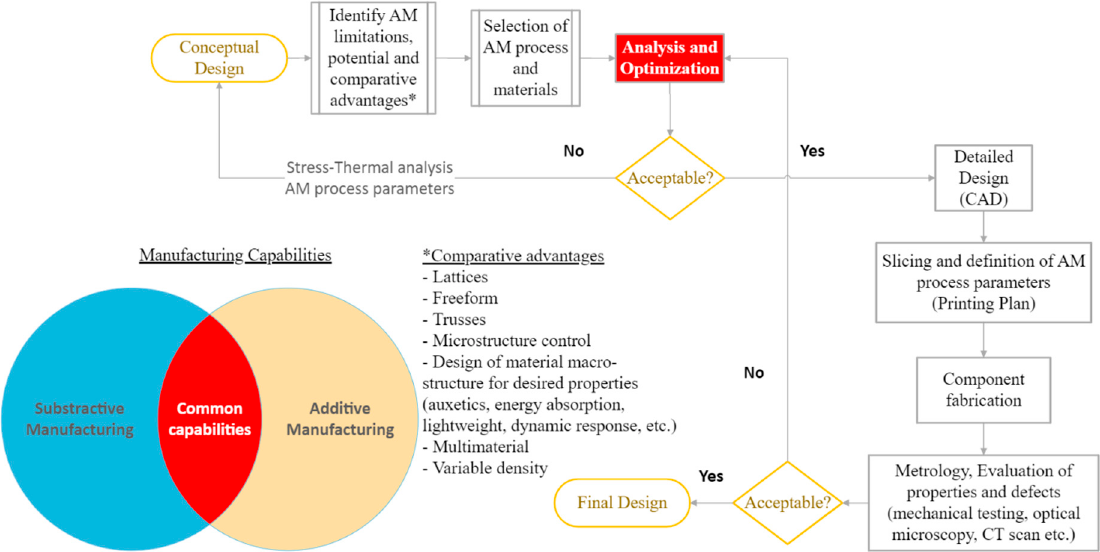
Figure 6. Design for Additive Manufacturing process.